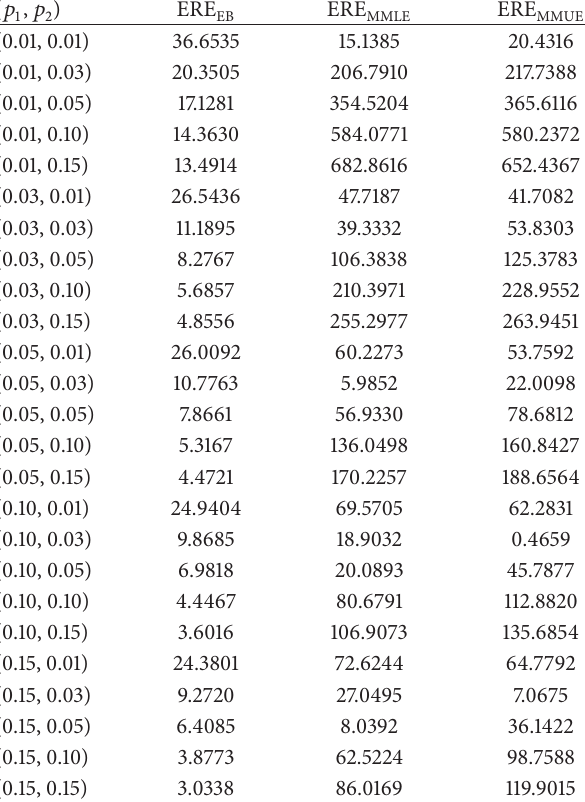
Table 4: The percentages of the Estimated Relative Error of odds ratio estimation for (𝑛 1 , 𝑛 2 ) = (10,10).